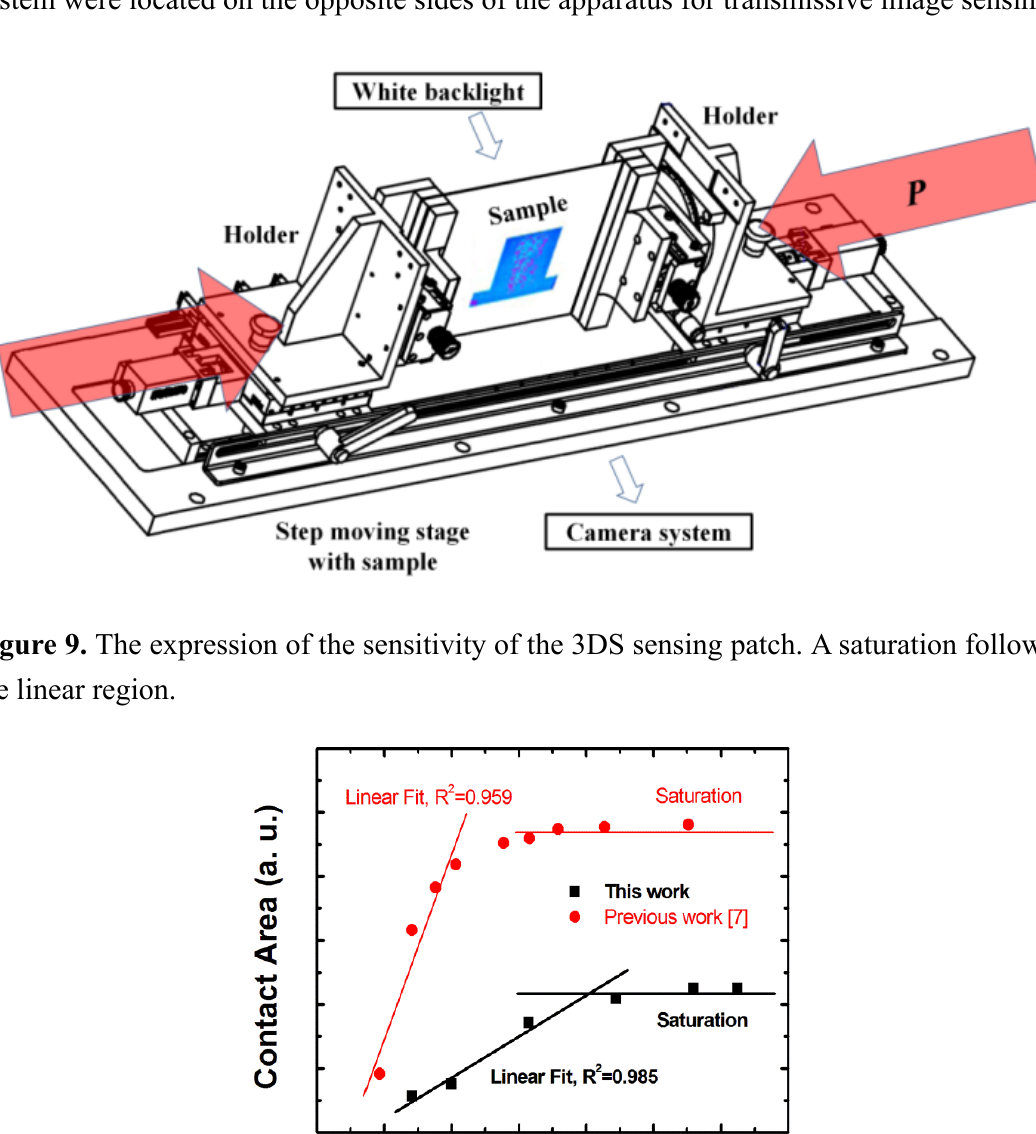
Figure 8. The setup of the step moving apparatus. The sample was placed between two holders and suffered balanced load from each side. The white backlight and the camera system were located on the opposite sides of the apparatus for transmissive image sensing.